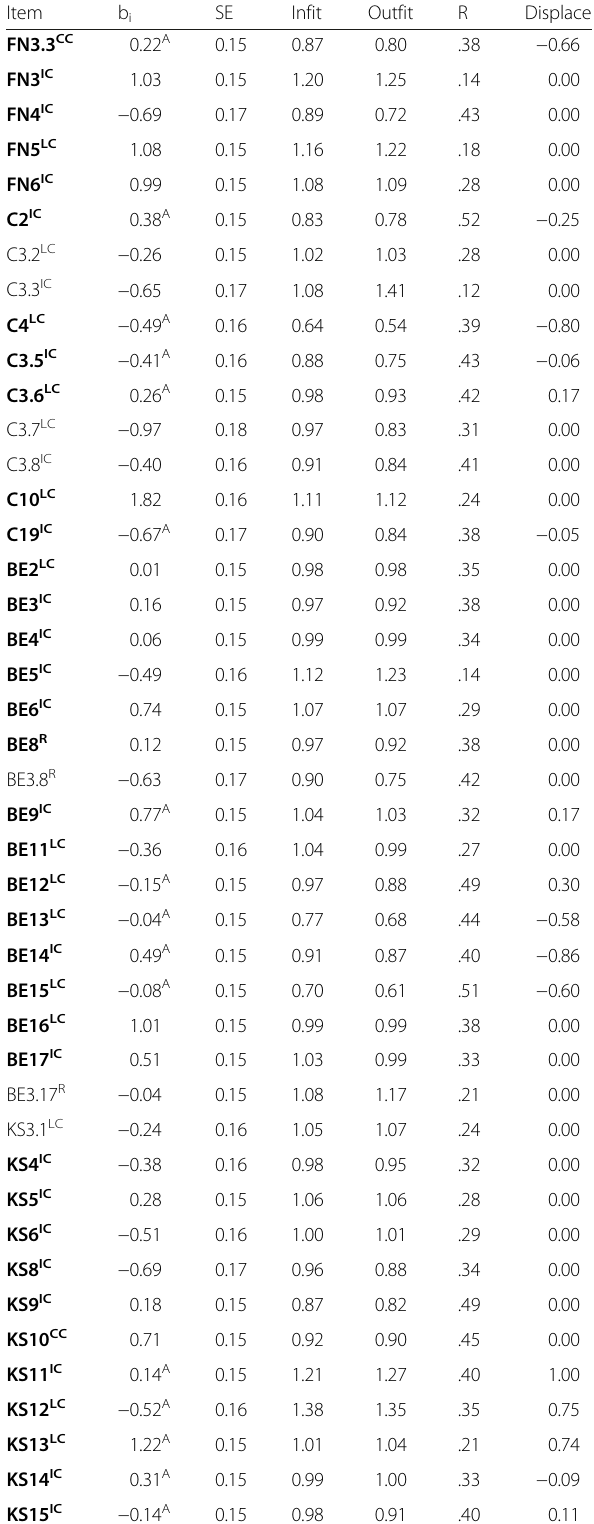
Table 6 Psychometric properties of the items of the TRC-e-3